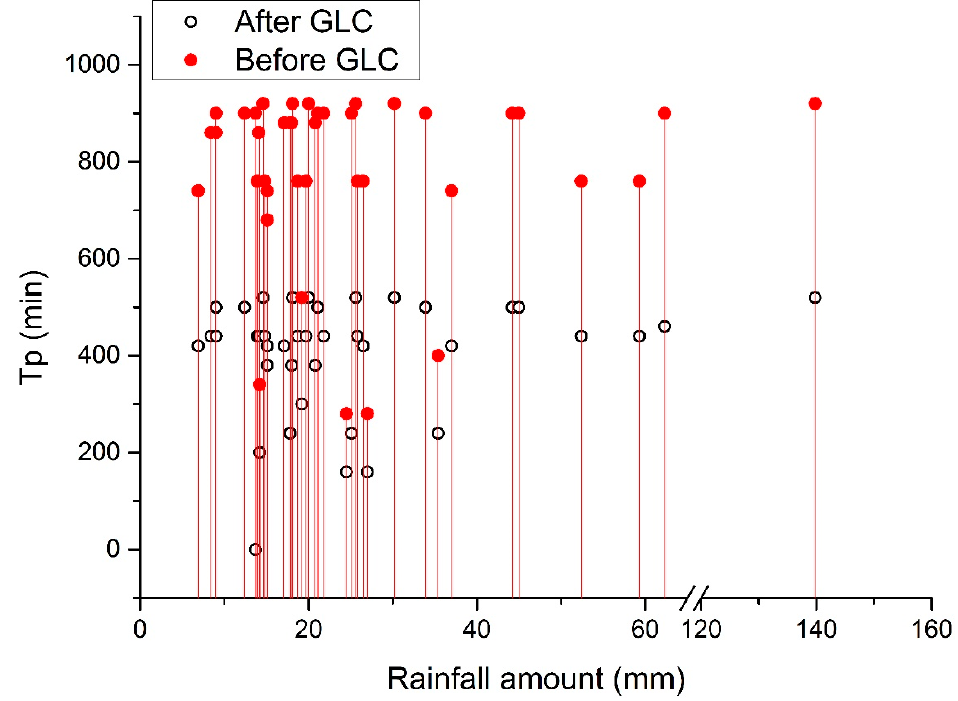
Figure 9. Time to the peak flow rate (T p ) before GLC (in 2013) and after GLC (in 2019).